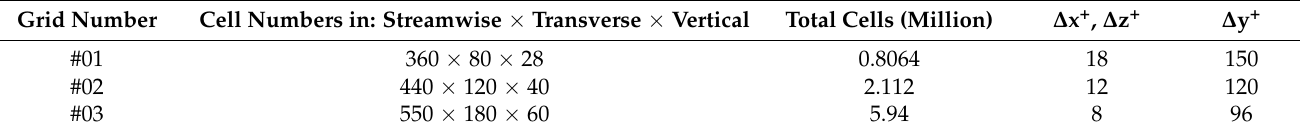
Table 2. Configurations of three sets of